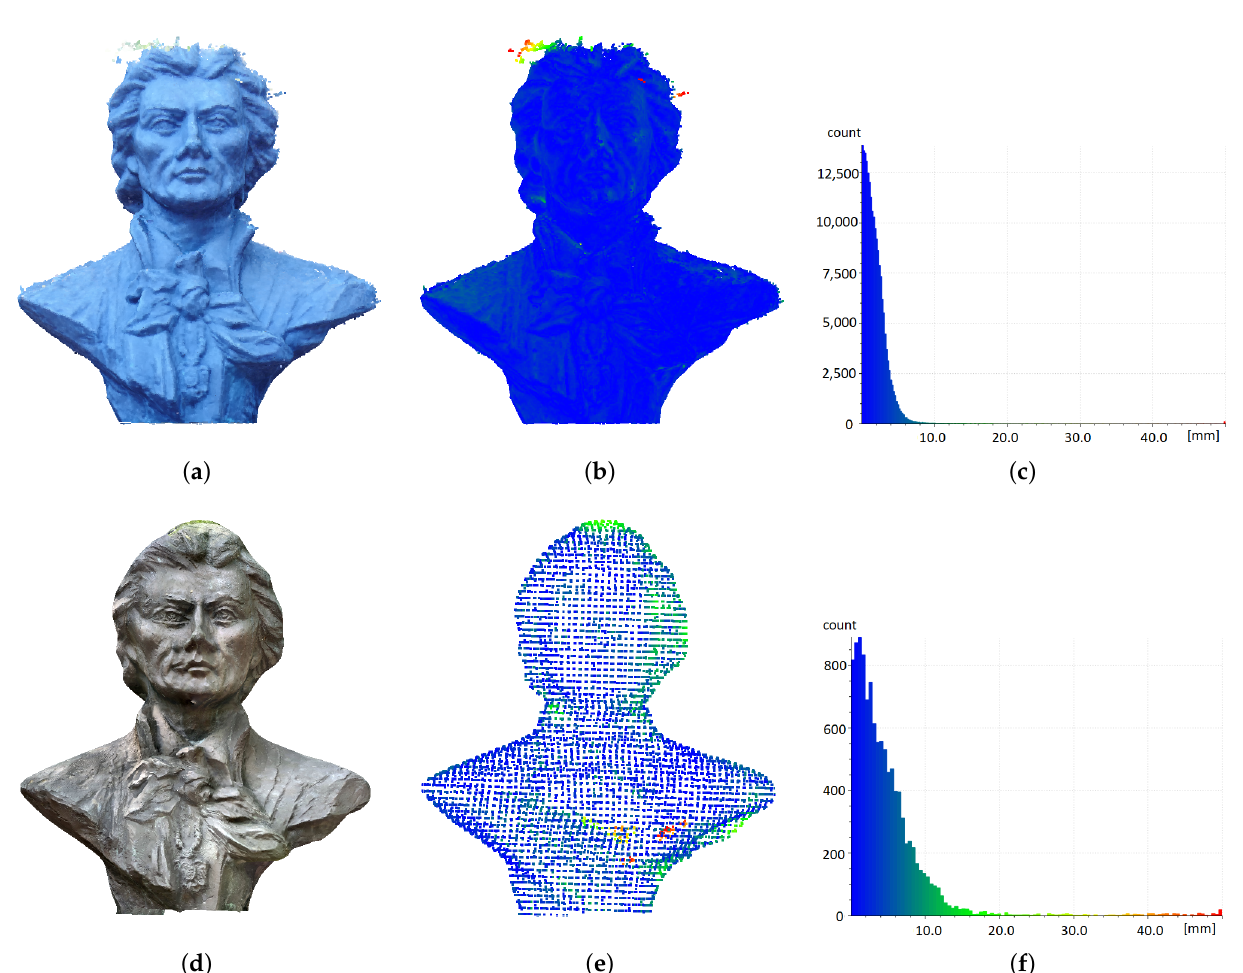
Figure 7. Comparison of measured data with the model for the small architectural object. Photogram- metry: ( a ) textured mesh, ( b ) point cloud, ( c ) histogram of distances to the model; iPad: ( d ) mesh, ( e ) point cloud, ( f ) histogram of distances to the model. Point clouds are coloured according to histogram